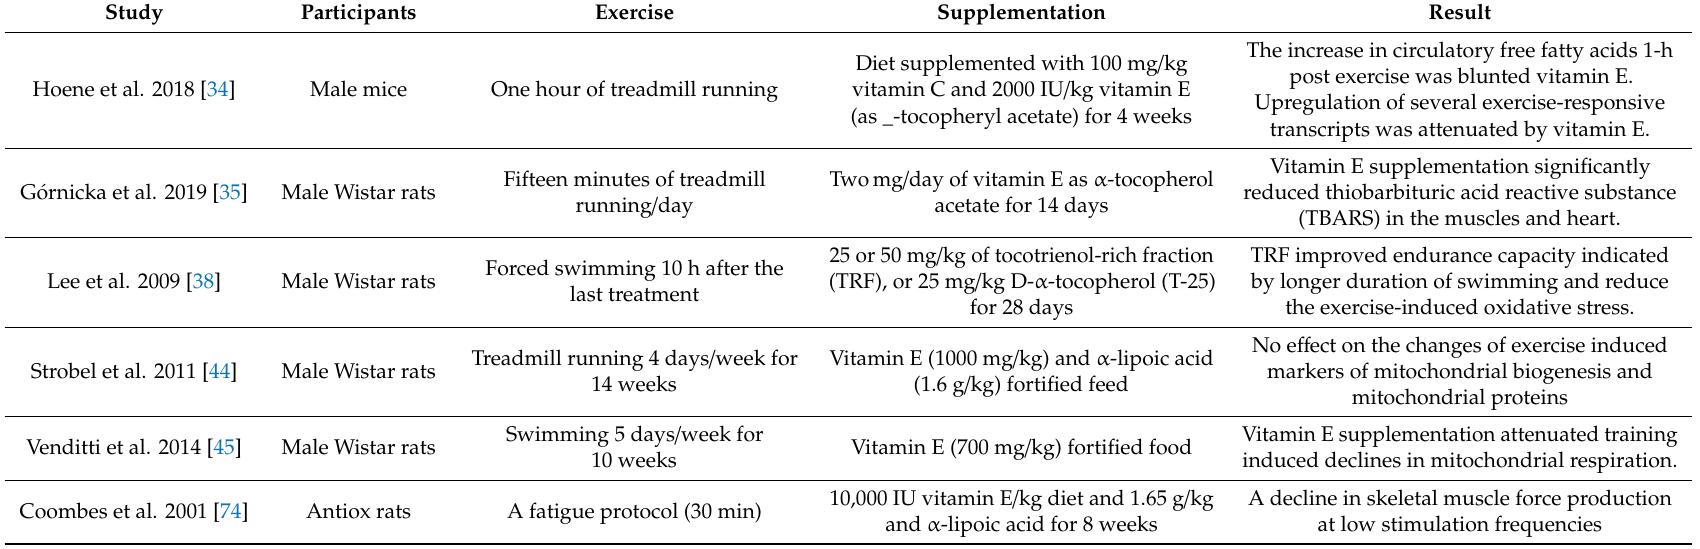
Table 2. E ff ects of vitamin E supplementation, with or without vitamin C, on exercise performance and oxidative stress markers in